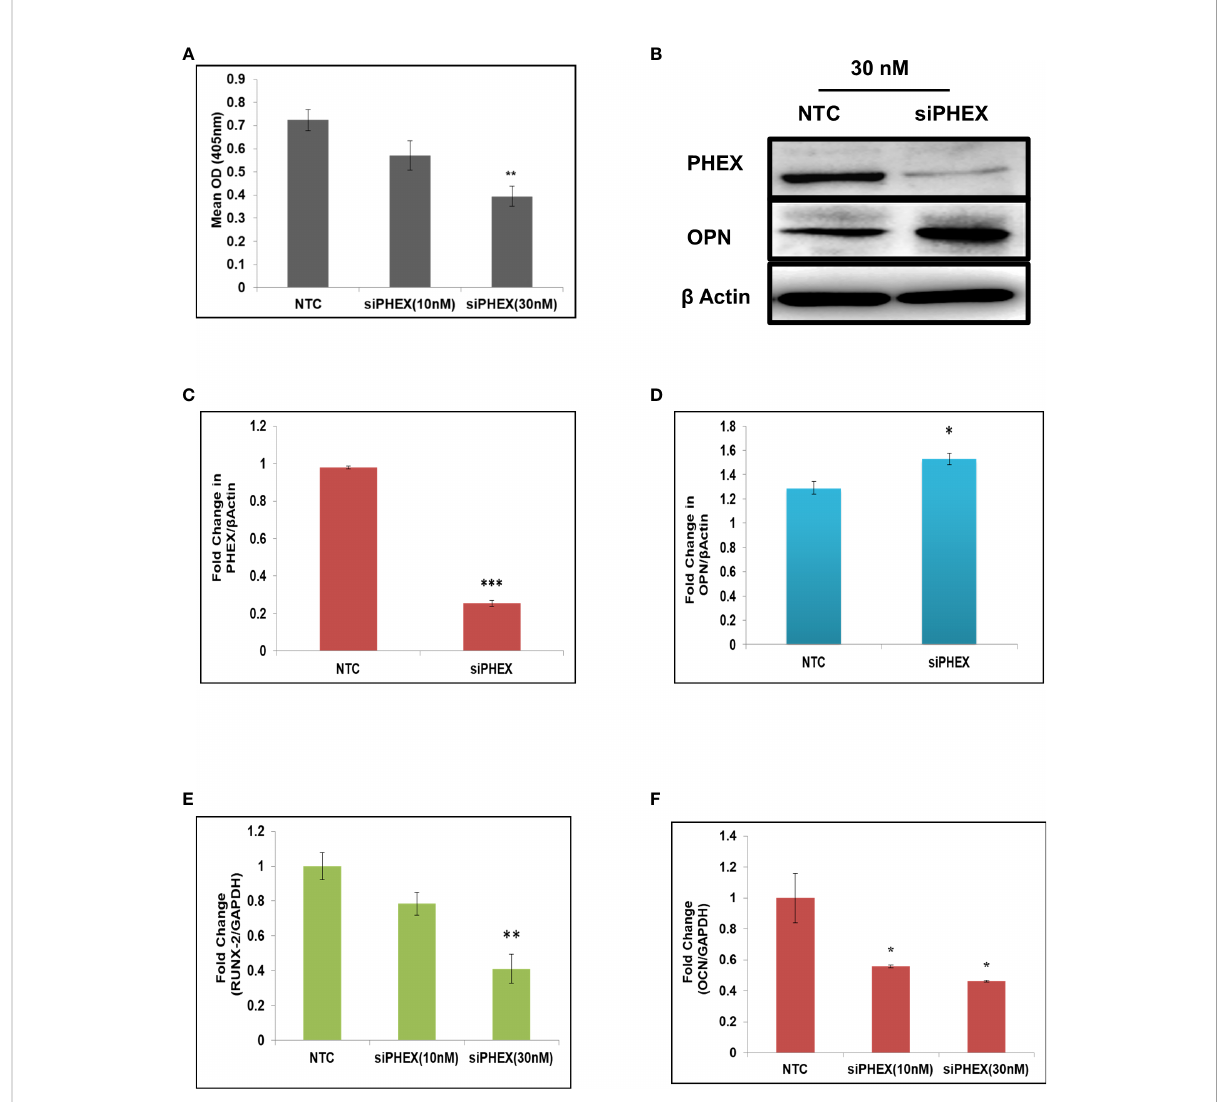
FIGURE 1 Silencing of phex inhibits osteoblast differentiation. (A) Murine osteoblasts transfected with different concentrations of silencer of phex and ALP activity measured at 48 h. (B) Western blot analysis of phex and OPN. (C, D) The relative expression of phex and OPN were quanti fi ed densitometrically by using ImageJ software. (E, F) qRT-PCR evaluation of osteogenic markers (RunX-2, and OCN) at 48 h. GAPDH was taken as internal control. The data is presented as mean ± SEM (n=6) *P < 0.05, **P < 0.01 and ***P < 0.001compared to NTC (scrambled